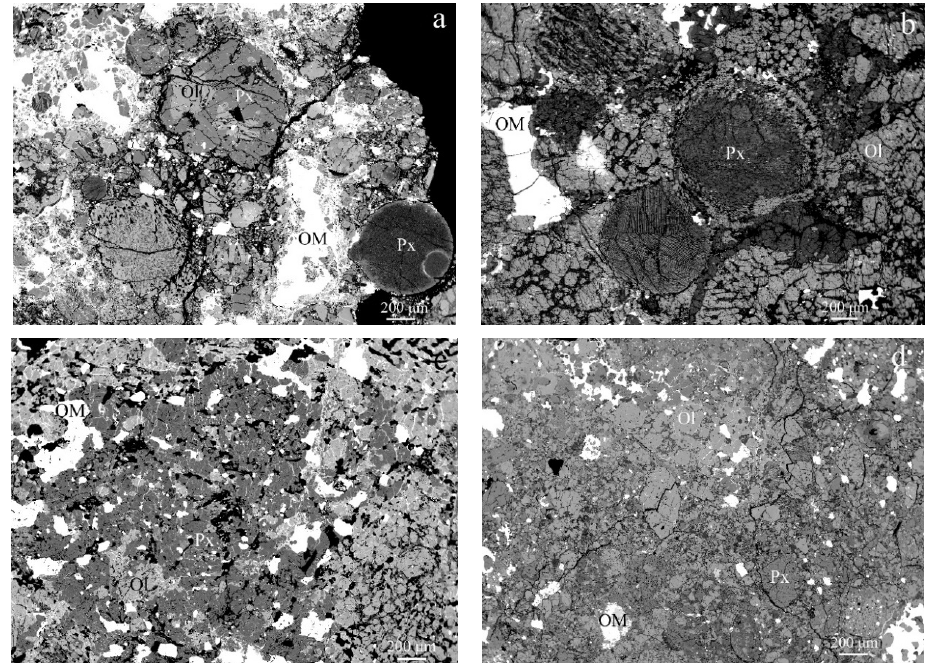
Figure 2. Back-scattered electron (BSE) images of representative equilibrated ordinary chondrites. ( a ) GRV 020008 (H4); ( b ) GRV 020038 (L4); ( c ) GRV 022178 (L6); ( d ) GRV 020041 (LL4). Ol—olivine, Px—pyroxene, OM—opaque mineral.